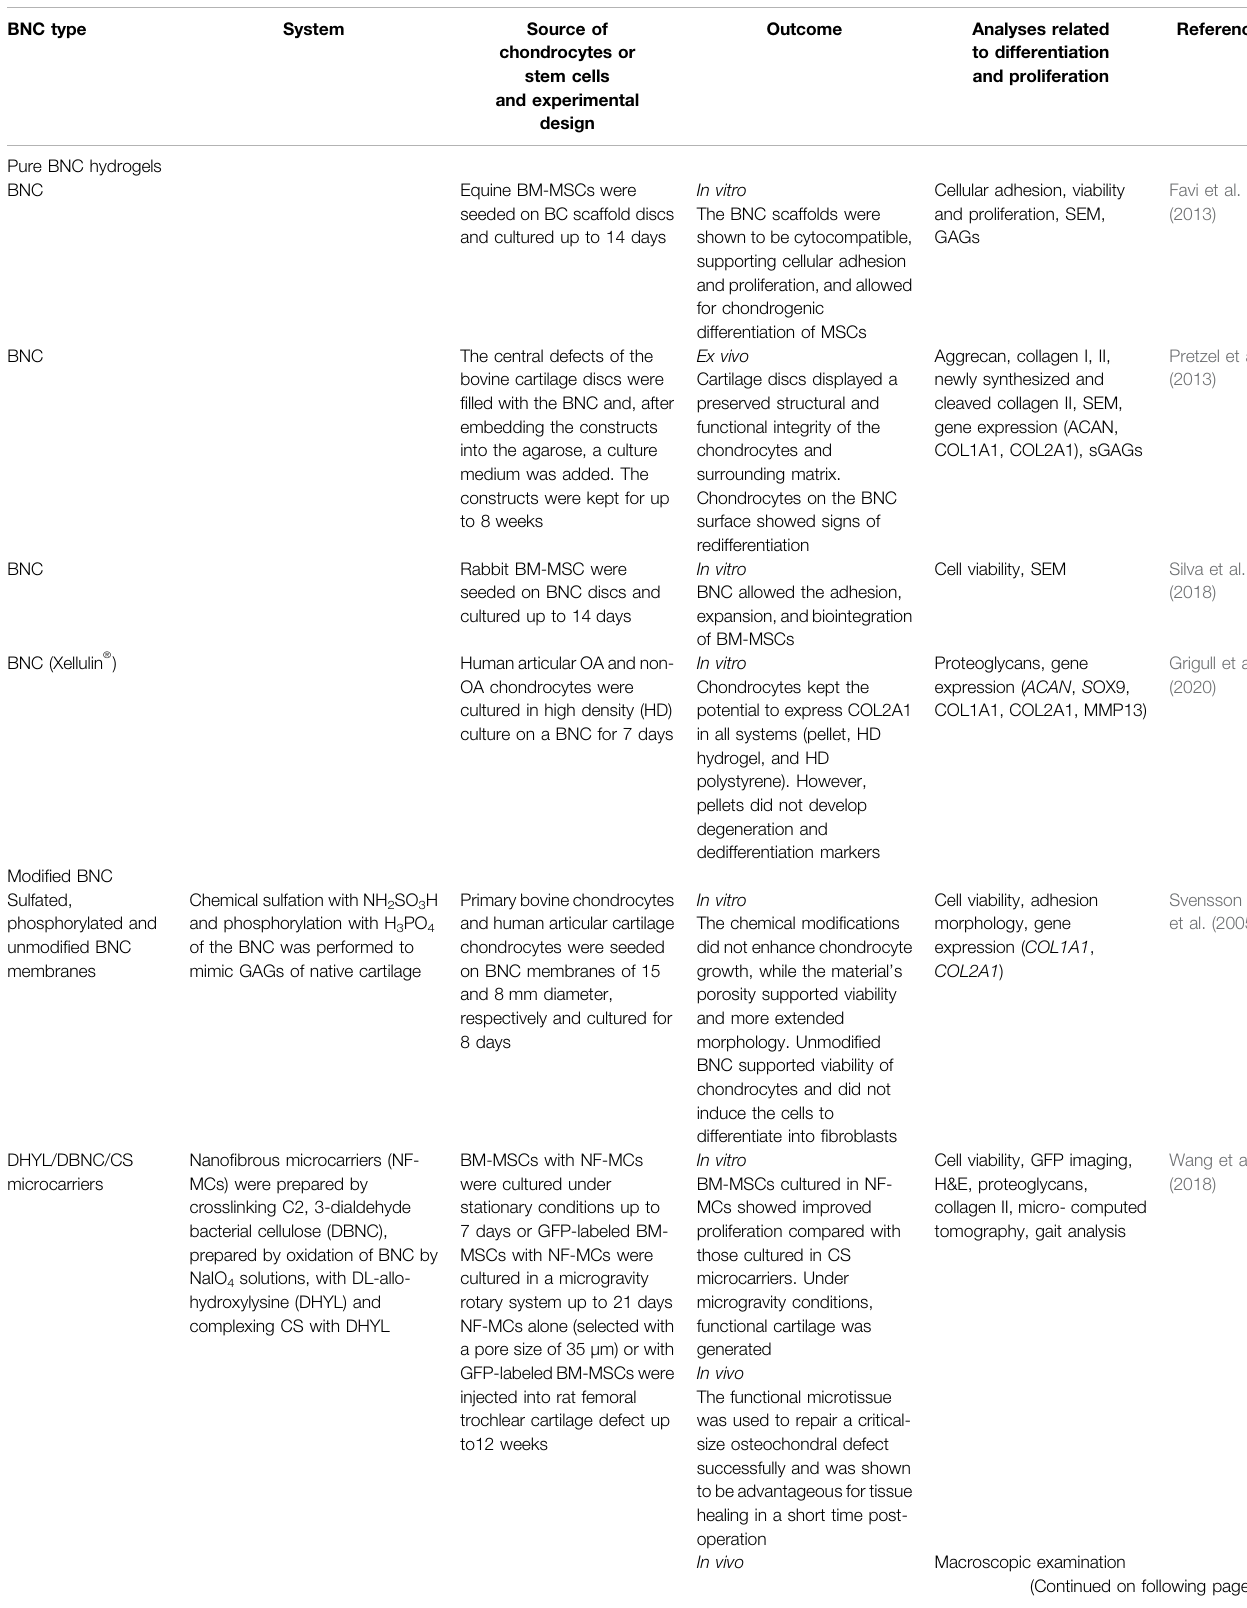
TABLE 3 | BNC applied to cartilage tissue